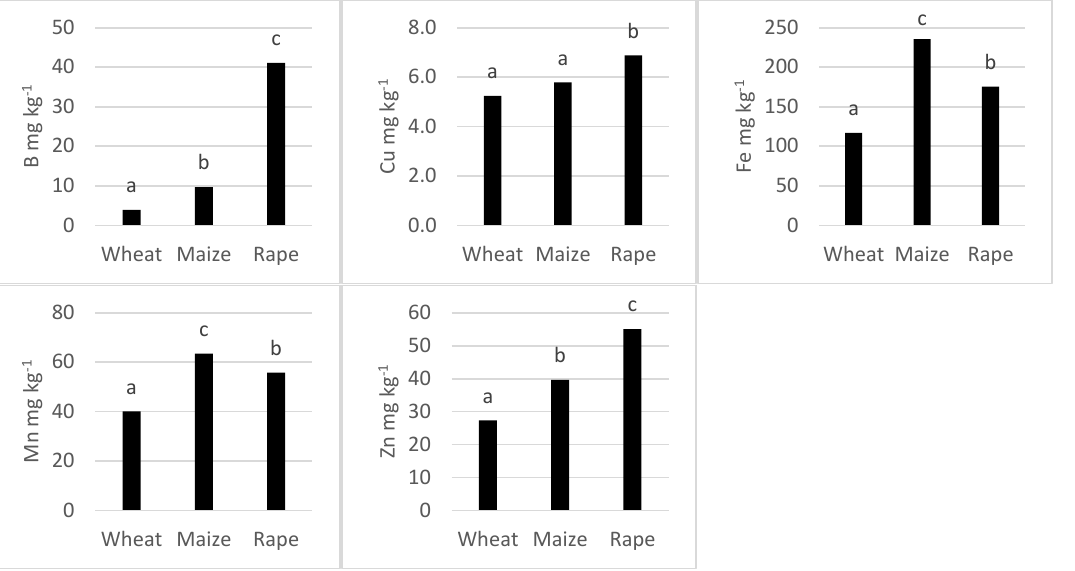
Figure 3. Concentration of micronutrients in shoots of the tested species — average of all collected samples. Bars marked with the same letters indicate no significant difference according to Tukey ’ s test ( p < 0.05).